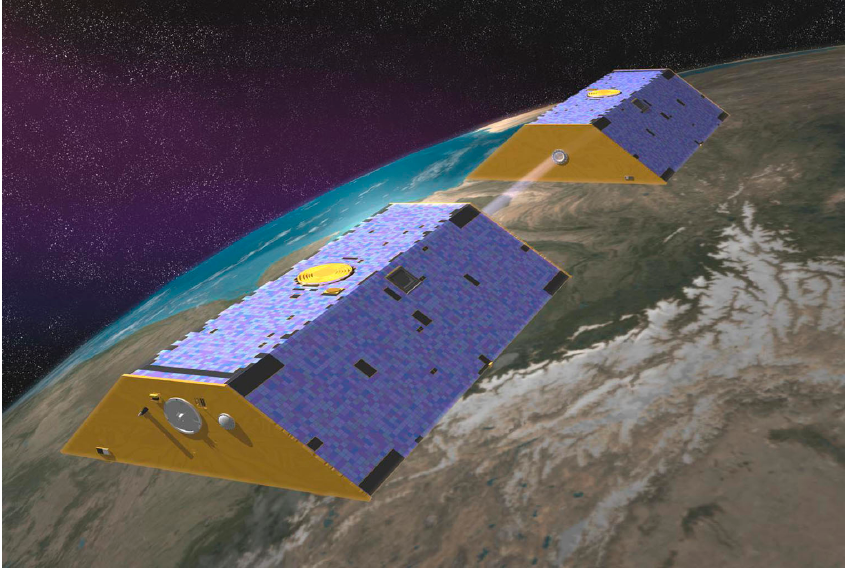
Figure 1. Artist view of the Gravity Recovery and Climate Experiment (GRACE) mission. Source: [34].